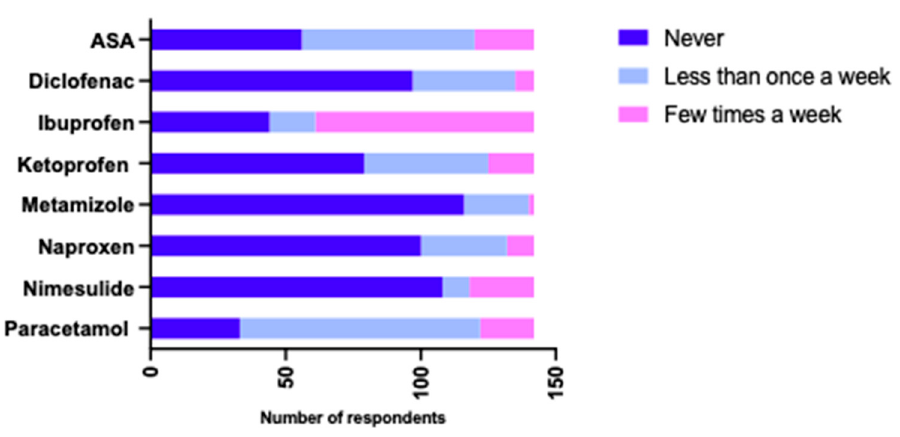
Figure 2. Analysis of the frequency of use of non-opioid analgesics by the elderly and older adults.